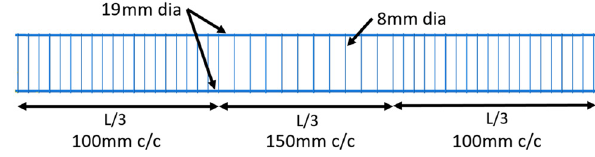
Figure 15: Details of the rebars in concrete beam.